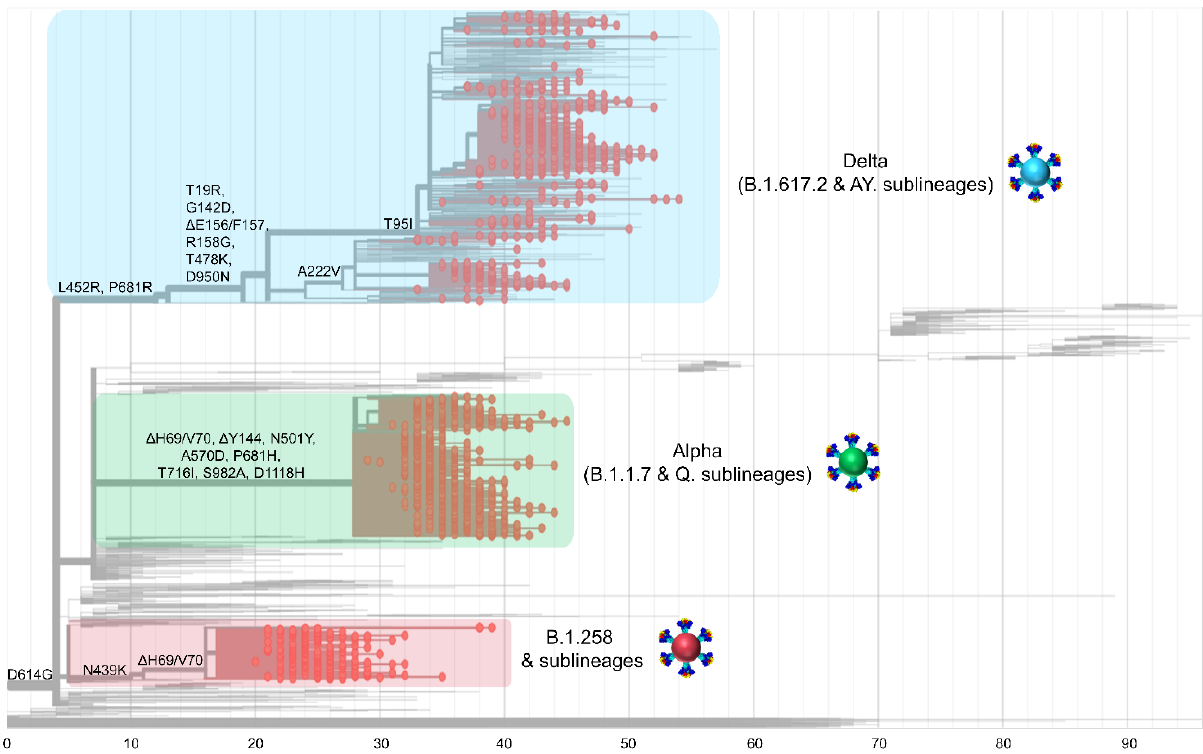
Figure 4. The phylogeny and S protein mutations of Cypriot SARS-CoV-2 sequences classified as B.1.258 & sublineages, Alpha (B.1.1.7 & Q. sublineages), and Delta (B.1.617.2 & AY. sublineages)